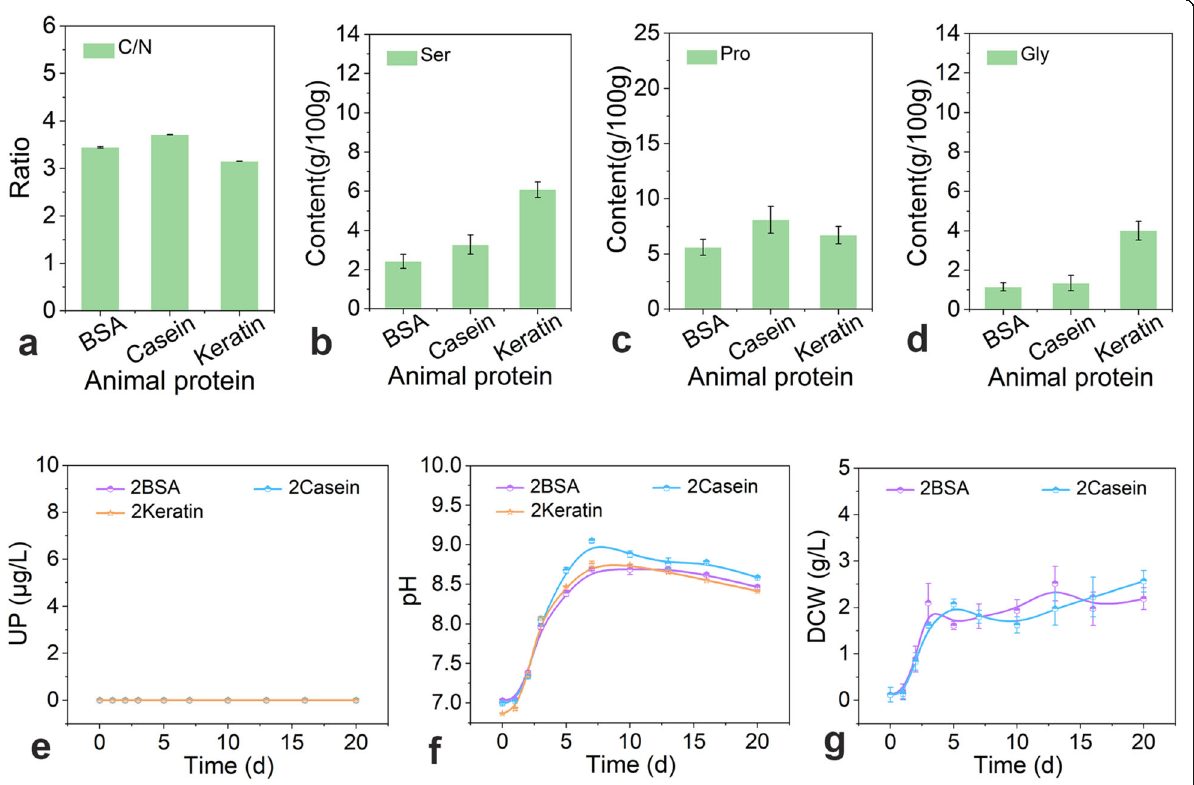
Fig. 6 The AAs characteristics and UP producing ability of the animal proteins by S. coelicolor . a The C/N ratio of the animal proteins including BSA, casein, and keratin. b - d The contents of Ser, Pro, and Gly in the three animal proteins, respectively. e and f The variations of UP concentrations and pH values in the 2BSA, 2Casein, and 2Keratin media, respectively, during the fermentation period of 20 d. g The change of DCW in the 2BSA and 2Casein media during the fermentation